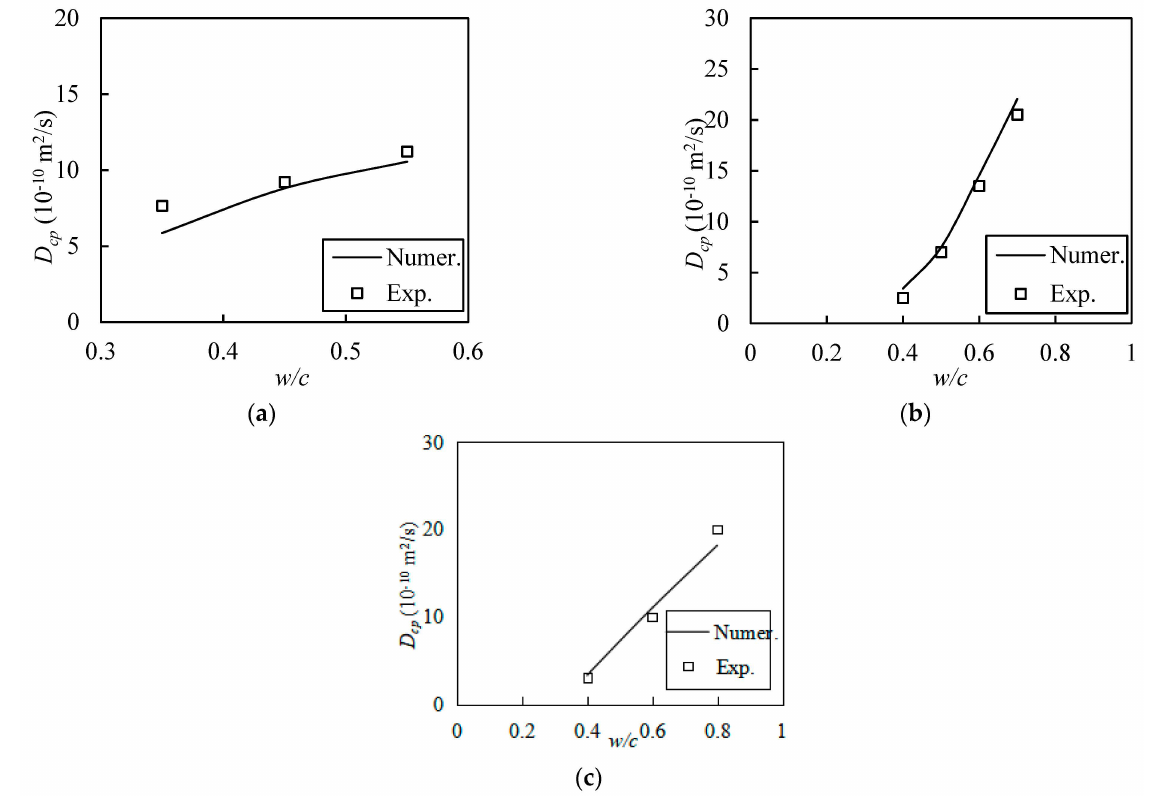
Figure 11. Comparison of numerical results with the experimental results: ( a ) from self-conducted experiments, ( b ) from MacDonald and Northwood [6], and ( c ) from Tang and Nilsson